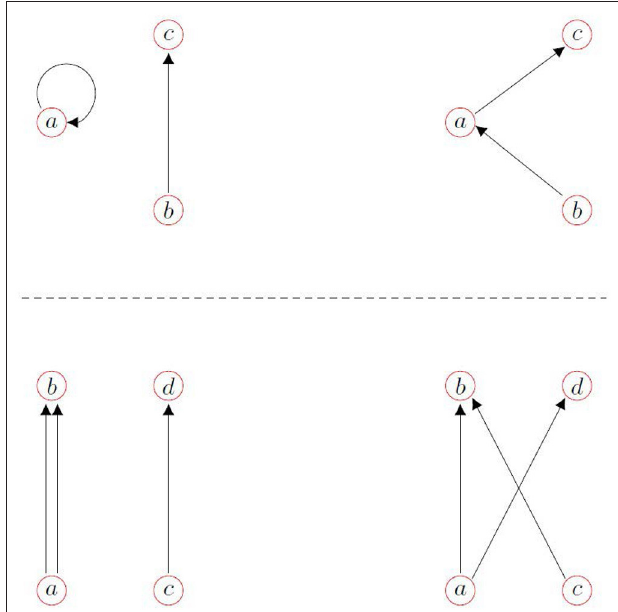
FIGURE 4 | (Top) We remove a self-connection to oscillator a (left) by rewiring the randomly chosen connection from oscillator b to c , giving the configuration at the right. (Bottom) we remove the double connection from oscillator a to b by rewiring the randomly chosen connection from oscillator c to d , giving the configuration at the right.